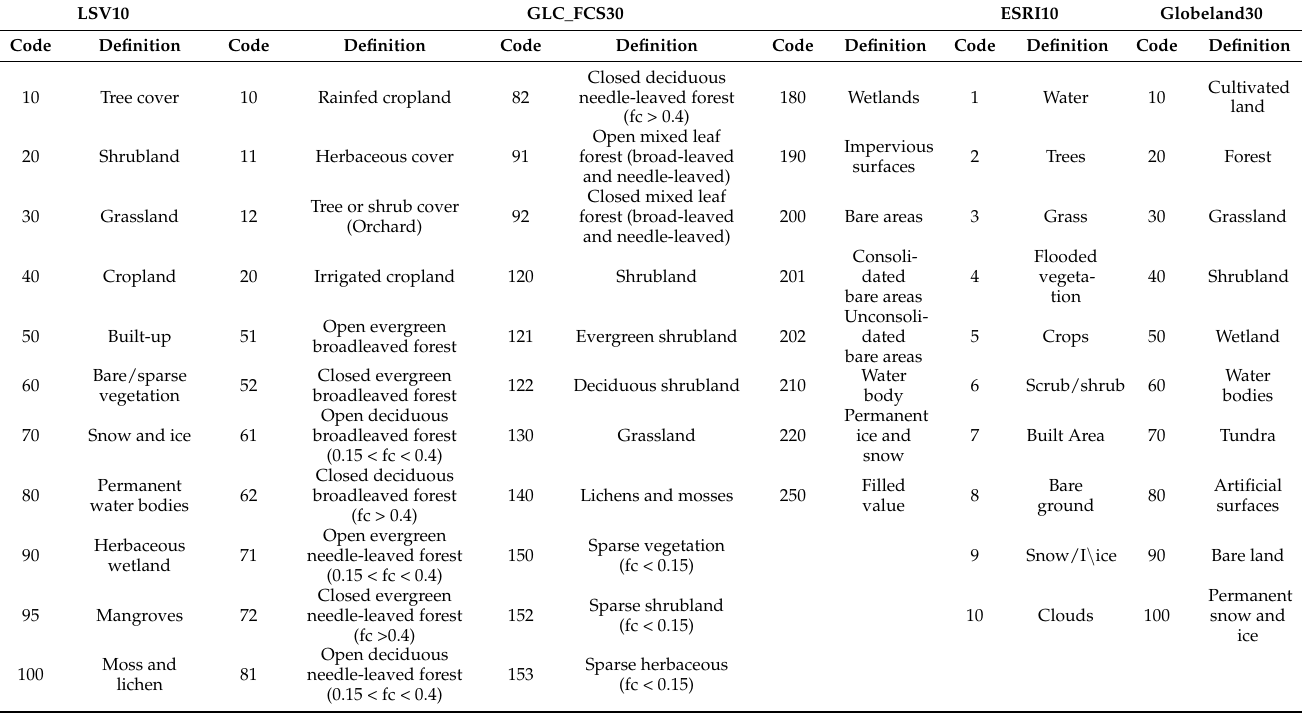
Table 2. Classification system of 4 LULC datasets.